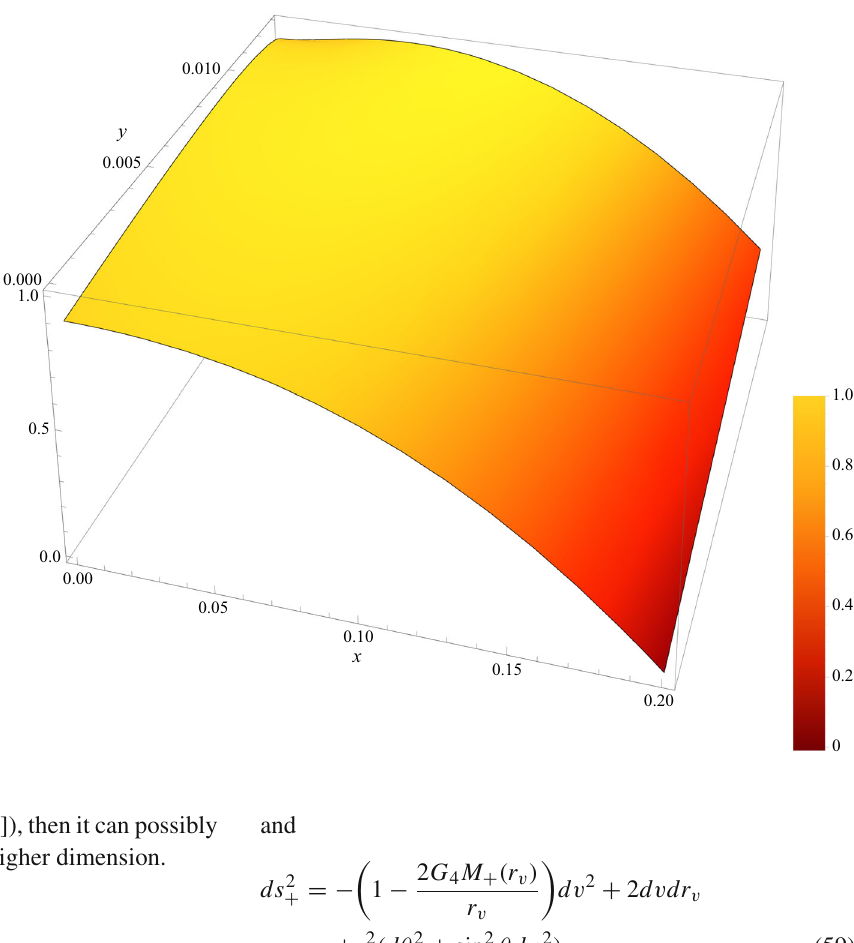
(cid:12) (cid:4) 2 ( = x ) vs G 4 r 2 0 0 r 0 ( = y ) (left U 0 rad 0